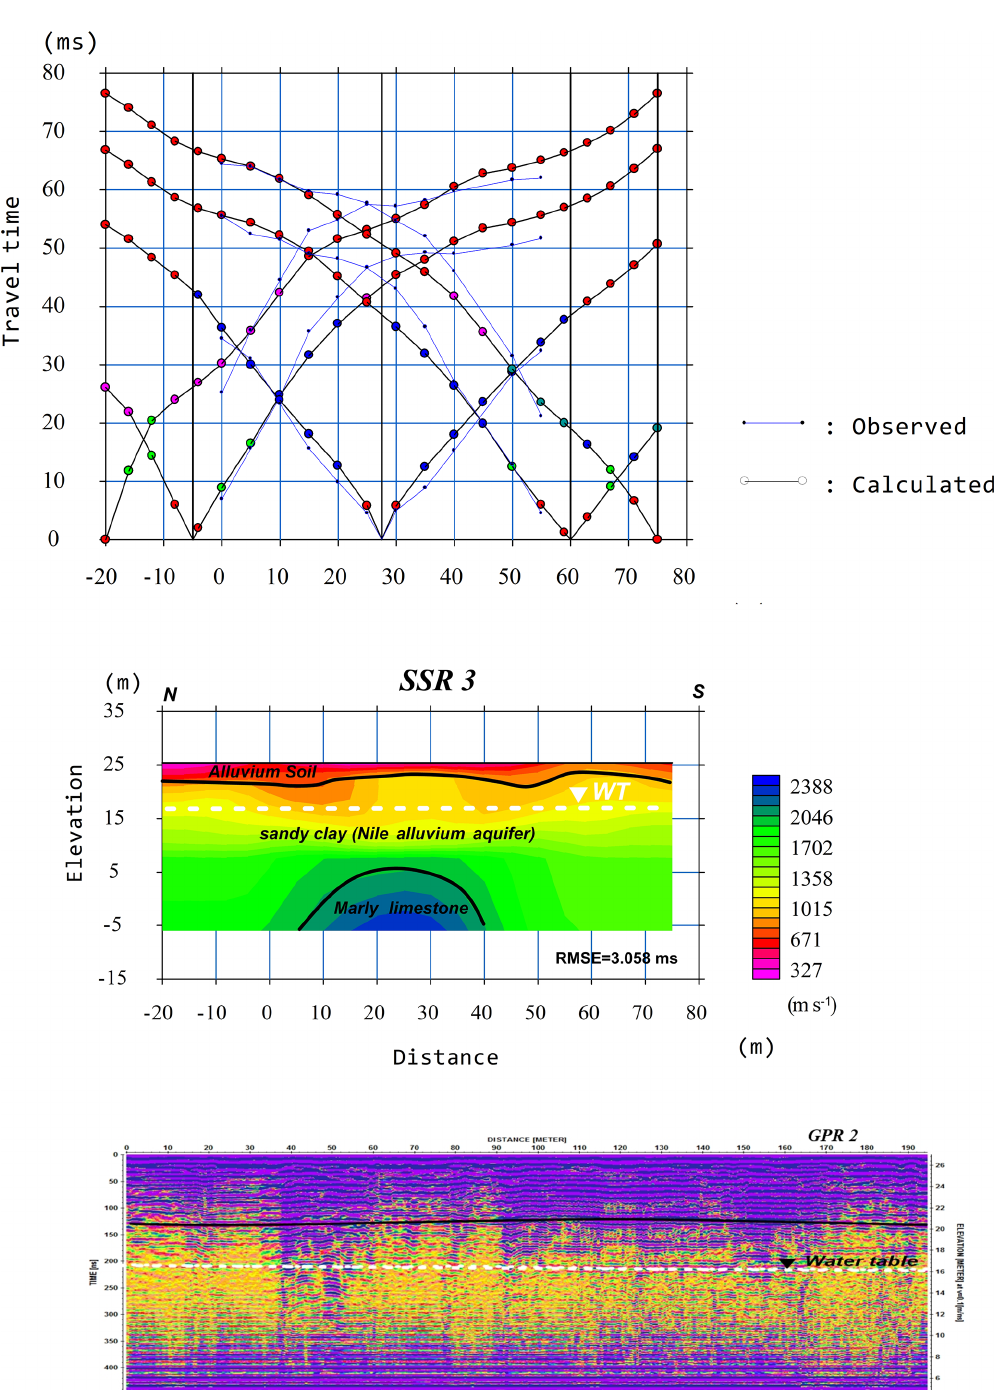
Figure 5. SSR and GPR profiles in Nazlet El-Samman